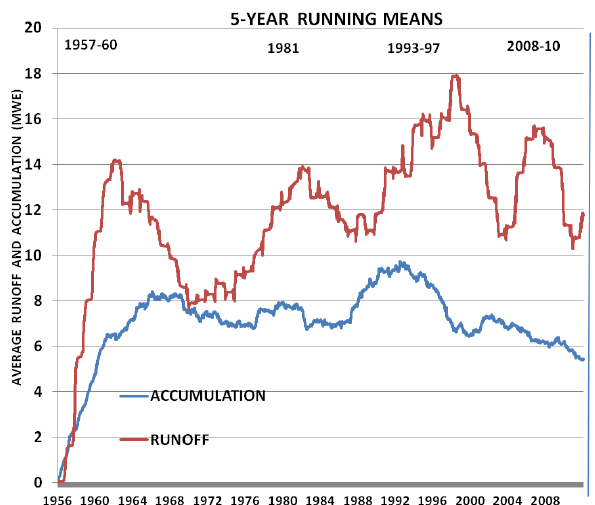
Fig. 10. Five-year running mean of daily runoff (ablation plus pre- Figure 10. Five-year running mean of daily runoff (ablation plus 481 cipitation as rain) and snow accumulation on Bering Glacier, and precipitation as rain) and snow accumulation on Bering Glacier, and 482 timing of four of the observed surges since 1951. The 1966–1967 timing of four of the observed surges since 1951. The 1966-67 surge 483 surge appears not to have affected appears not to have affected runoff. 484